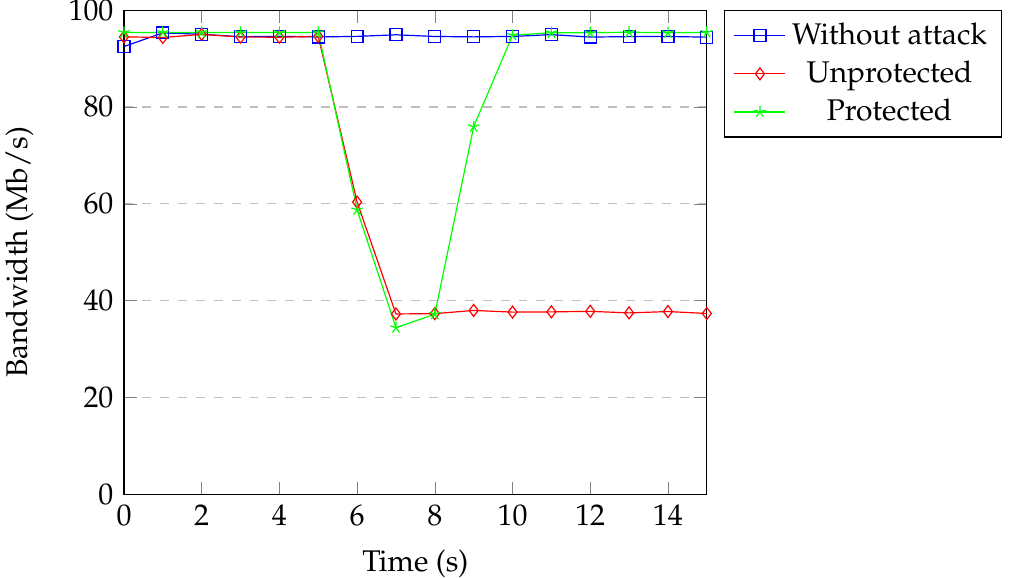
Figure 18. Available bandwidth under SYN flood with spoofing.